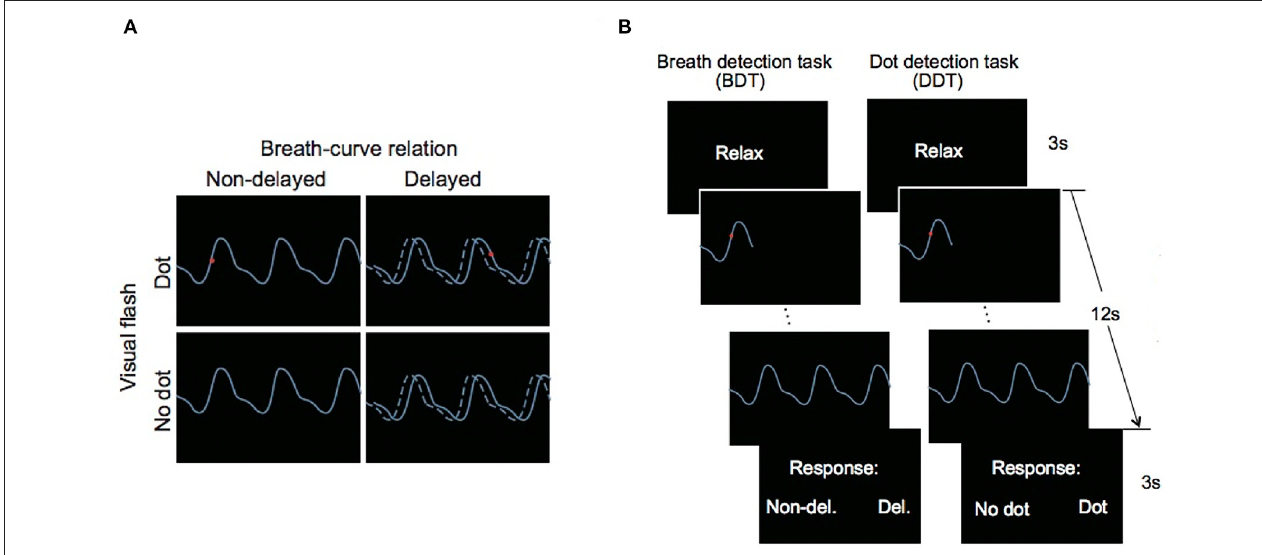
FIGURE 1 | (A) Possible conditions. The solid line represents the respiratory curve displayed on the screen. The dashed line represents the actual breathing curve. (B) Sample of a trial in the breath detection task (BDT) and the dot flash detection task (DDT). Adapted from Wang et al. (2019).